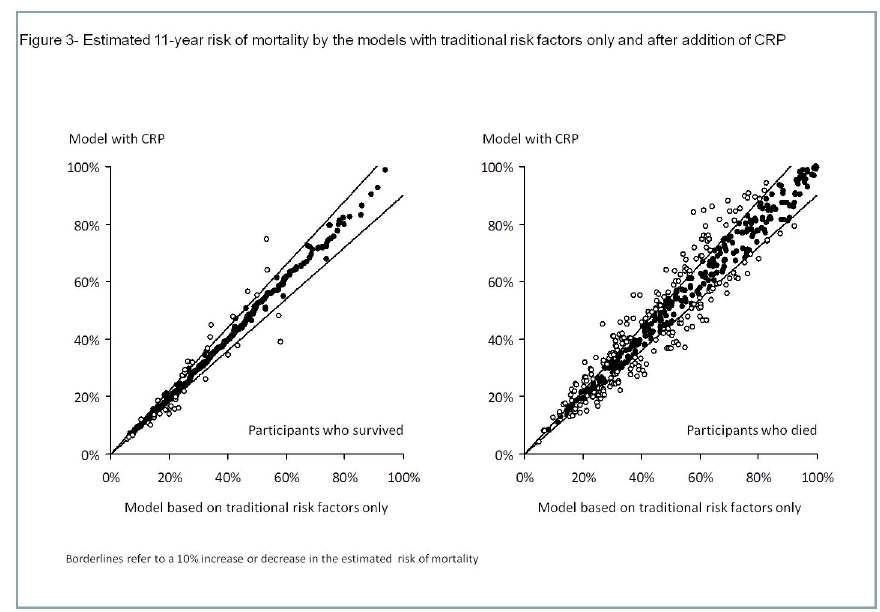
Figure 3. Estimated 11-year risk of mortality by the models with traditional risk factors only and after addition of CRP.